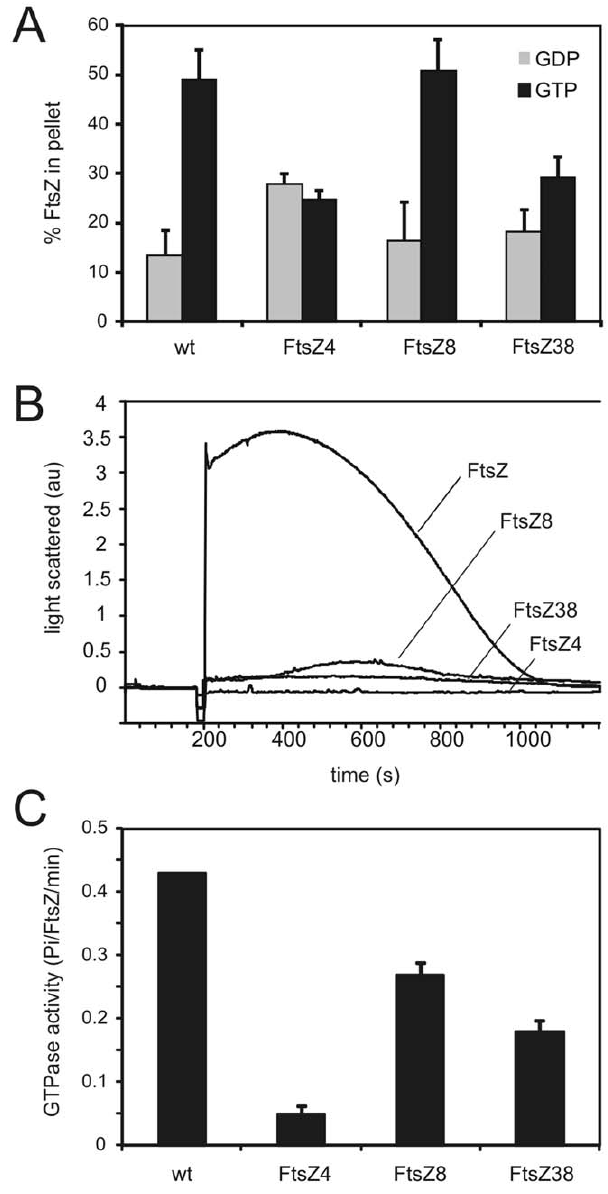
Figure 2. Polymerization and GTPase activity of the FtsZ mutants. (A) Sedimentation assay. Wild type and mutant FtsZ (10 m M) was incubated in 50 mM Hepes/NaOH; 50 mM KCl; 10 mM MgCl 2 ; pH 7.5 polymerization buffer at 30 u C. Polymerization was induced by addition of 1 mM GTP (or 1 mM GDP as control) and after 5 mins incubation at 30 u C, polymers were recovered by ultracentrifugation. The amount of pelleted FtsZ was quantified as described in material and Methods. Mean + SD from three independent experiments are shown. (B) Light scattering. FtsZ (10 m M) was incubated in 50 mM Mes/ NaOH; 50 mM KCl; 10 mM MgCl 2 ; pH 6.5 polymerization buffer After 3 min. baseline recording, GTP was added to 1 mM. pH 6.5 polymer- ization buffer was used as this results in a more readily detectable light scattering signal [21,38]. (C) GTP hydrolysis. Wild type and mutant FtsZ (10 m M) was incubated in 50 mM Hepes/NaOH; 50 mM KCl; 10 mM MgCl 2 ; pH 7.5 polymerization buffer at 30 u C. After addition of GTP to 1 mM, the release of phosphate was followed by a colorimetric assay and the GTPase activity was determined over 30 mins within the linear range of phosphate release. Mean + SD from three independent experiments are shown.